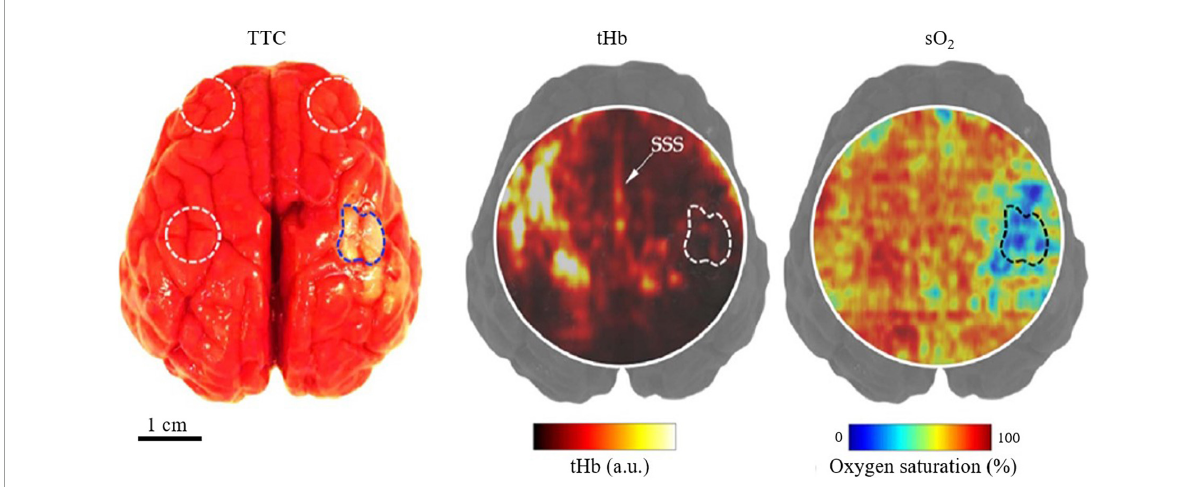
FIGURE4 Structural and functional PACT images of a neonatal pig in vivo with PT stroke (Kang et al., 2022). (Left) TTC staining of harvested brain (post-imaging) with dotted regions indicating the regions-of-interest (ROI) for imaging. (Middle) PACT image of total hemoglobin concentration of a transverse brain section, showing the stroke-induced hypoperfusion, with the stroke-infarct ROI marked by the dashed line. SSS, superior sagittal sinus. (Right) Corresponding PA image of the blood oxygenation, showing the stroke-induced tissue hypoxia.